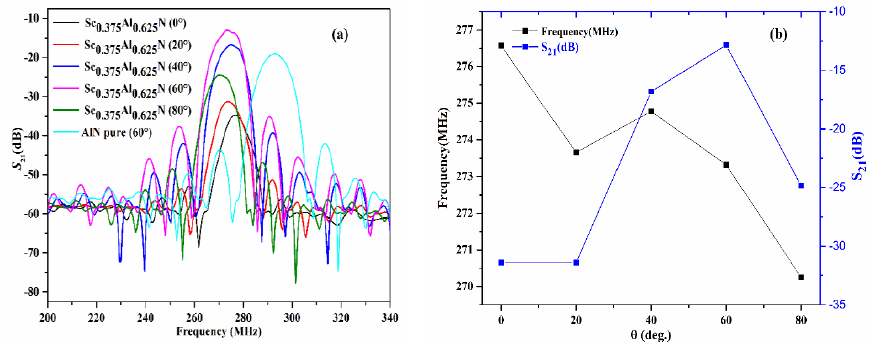
( b ) Insertion loss ( S 21 ) and frequency of SAW delay line without PnCs versus the c -axis tilted angle ( θ ◦ ) of w-Sc 0.375 Al 0.625 N